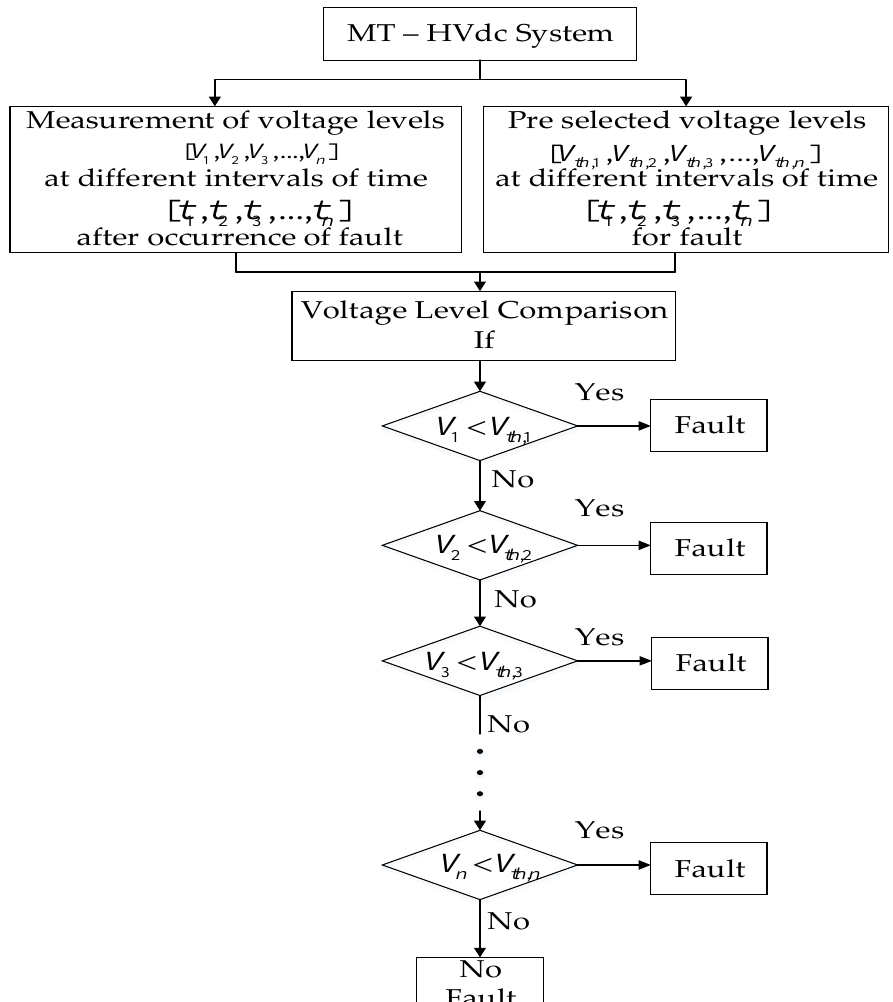
Figure 24. Non-traveling wave (NTW) method based on level of dc voltage detection.